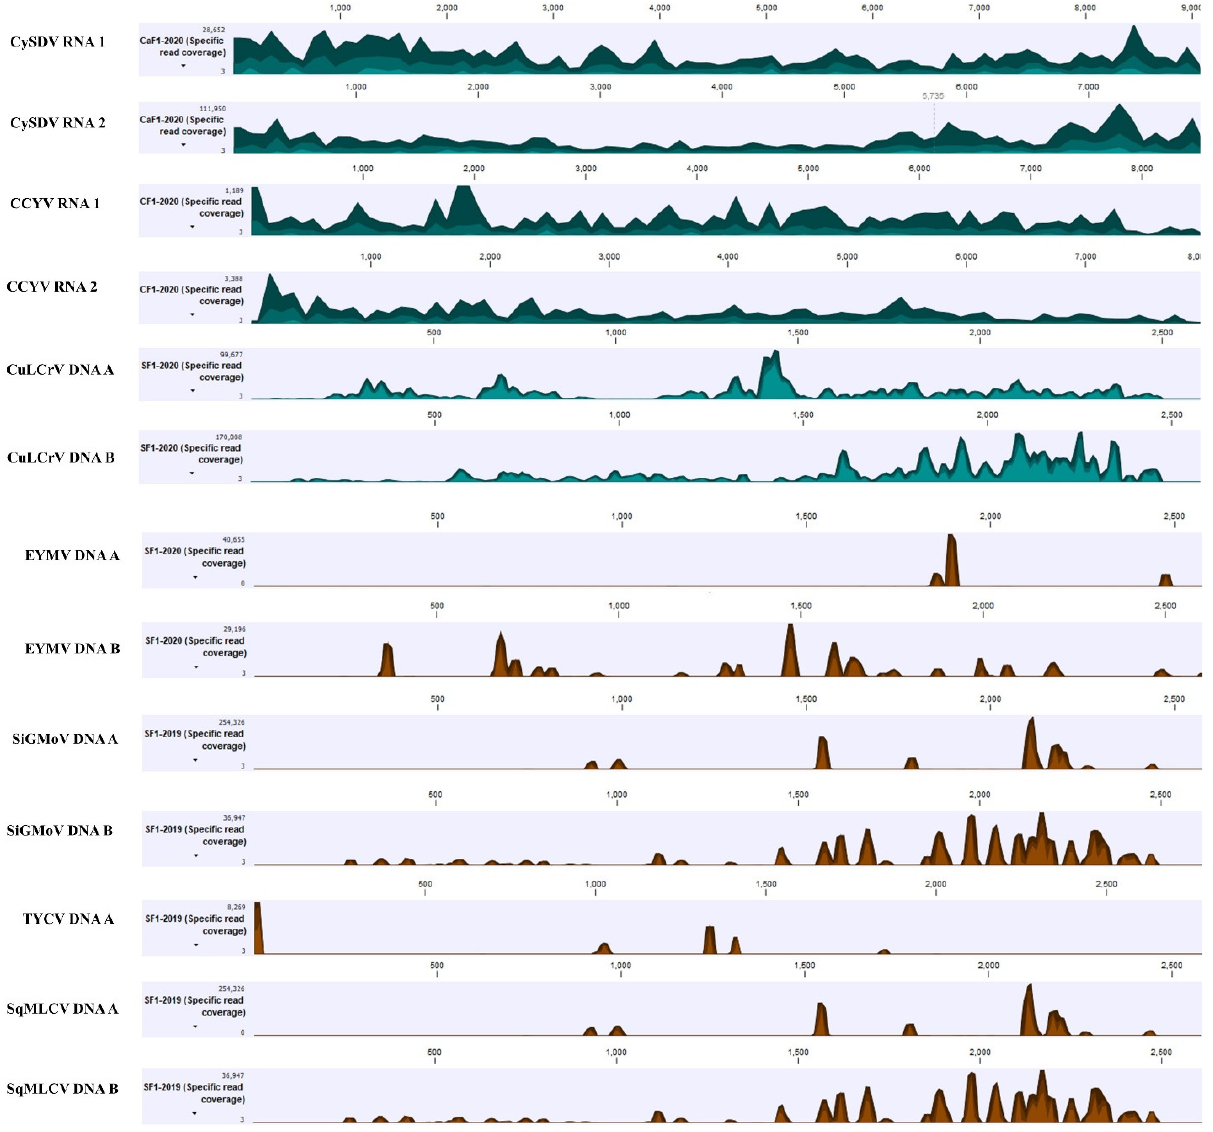
Figure 3. Read coverage maps of the viruses detected by high throughput sequencing of small RNAs of symptomatic cucurbits from Georgia. Scaled genome positions of the virus are shown above the histograms and the Y-axis represents the coverage in number of reads. Within the specified aggregation bucket, from top to bottom, the colors mean: The maximum coverage value (read count), the average coverage value, and the minimum coverage value. Abbreviations used for the viruses: Cucurbit chlorotic yellows virus (CCYV), cucurbit yellow stunting virus (CYSDV), cucurbit leaf crumple virus (CuLCrV), euphorbia yellow mosaic virus (EYMV), squash mild leaf curl virus (SqMLCV), sida golden mottle virus (SiGMoV), and tomato mild yellow leaf curl virus (TmYLCV).